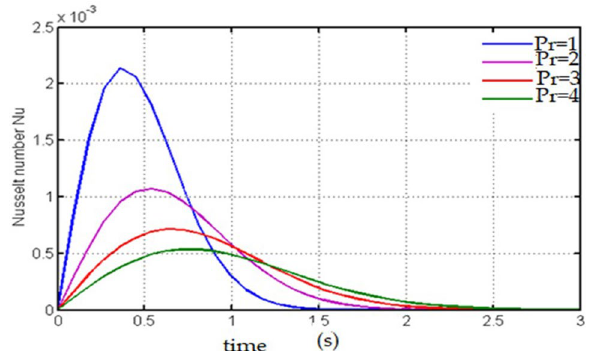
Figure 11. Plot for Nusselt number versus time against